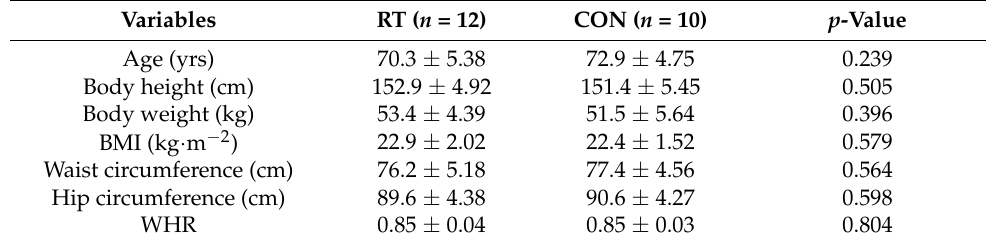
Table 1. Baseline characteristics of the participants (M ±